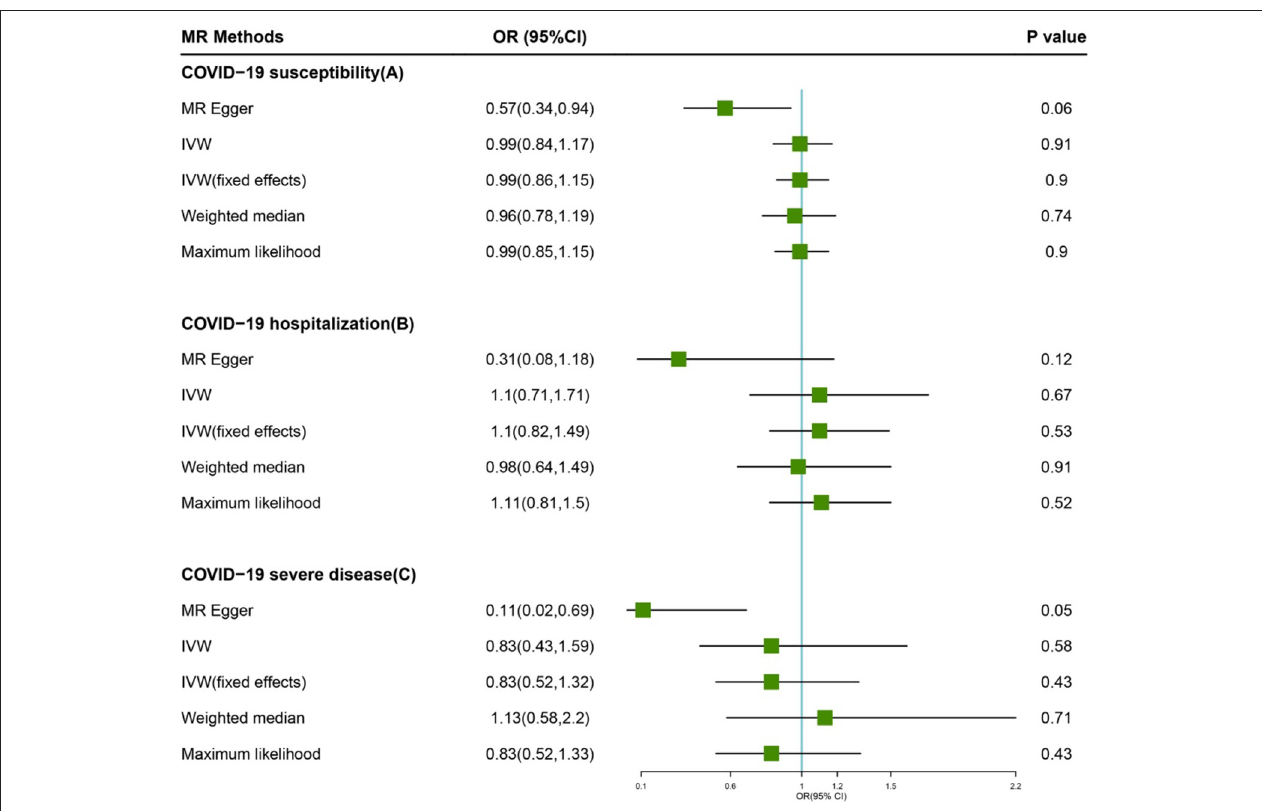
FIGURE 1 | Forest plot of MR study using genetic instruments with COVID-19. (A) COVID-19 susceptibility, (B) COVID-19 hospitalization, (C) COVID-19 severe diseas. OR, odds ratio; IVW, inverse variance weighted; CI, confidence interval; MR, Mendelian randomization.